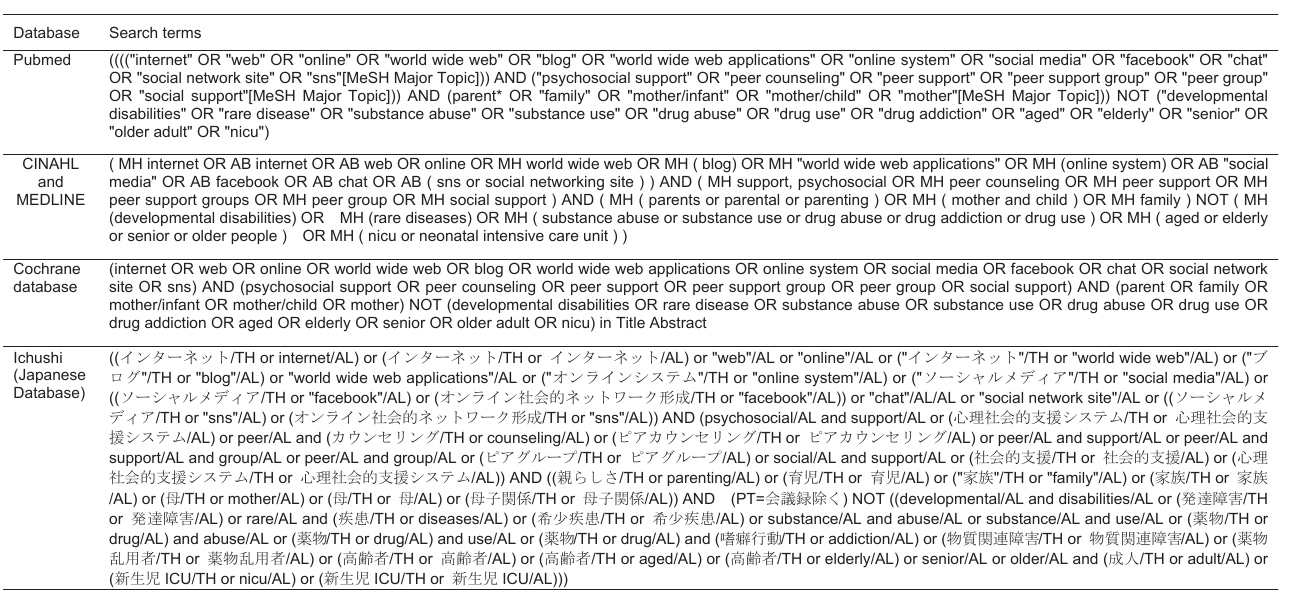
Table 1. Search terms used in literature